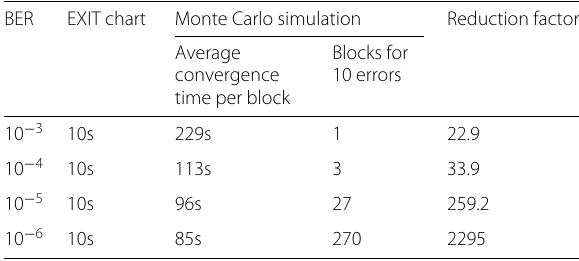
Fig. 9 BER vs SNR behavior of the obtained codes for p 0 = 0.5, p 0 = 0.8, and p 0 = 0.95. The Shannon limits (continuous lines) and the predicted decoding threshold (dashed lines) are plotted as vertical lines. An AWGN channel is considered